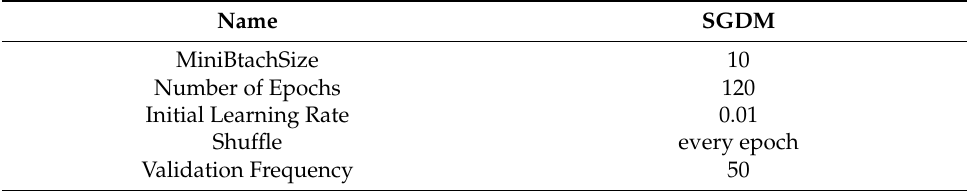
Table 3. Parameter values used in training networks.